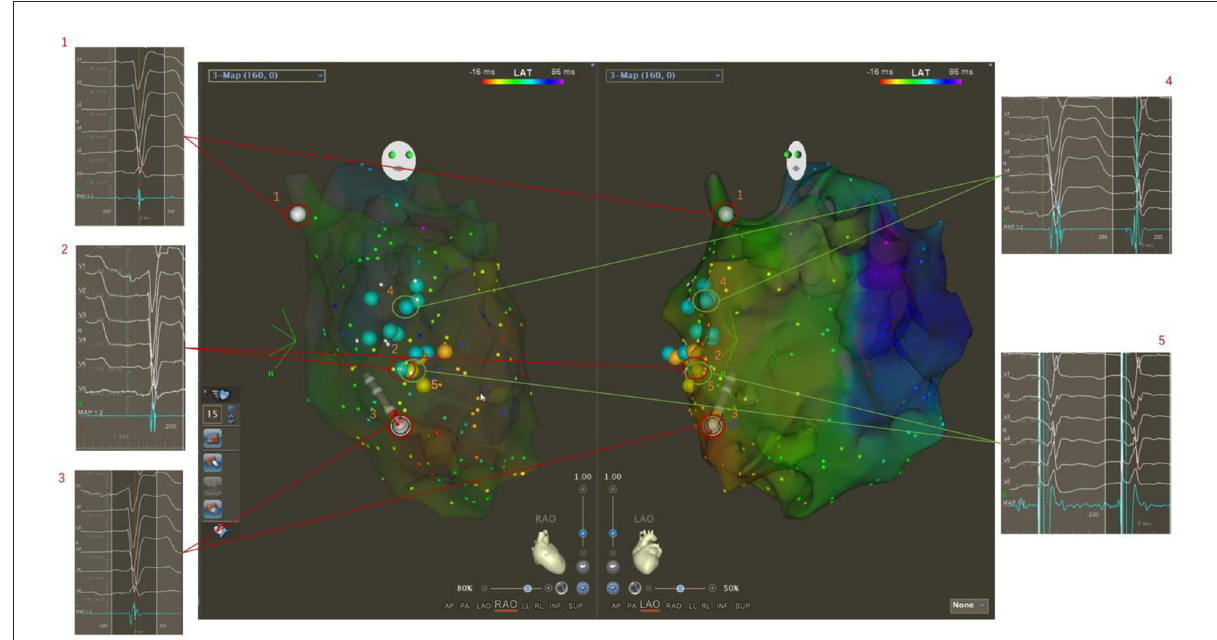
FIGURE2 Three-dimensional electroanatomical mapping showing delayed conduction of the left bundle branch. The potentials of His and the left bundle branch were not mapped from the bottom to the apex of the left ventricular septum (1, 2, 3). The occasional mechanical stimulation in the left bundle branch area increased the potential and induced the subsequent narrow premature ventricular contraction (4). Then, electrical stimulation was performed in the upper middle area of the left bundle branch, and a QR or rSR morphology in the surface lead V1 was seen, which indicated there was a left bundle branch block or slow conduction. In the next step, LBBAP was planned